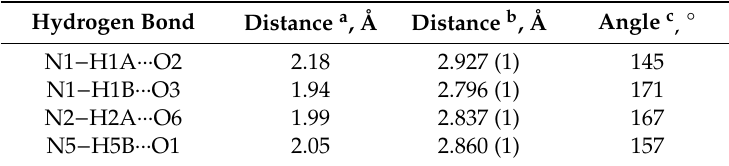
Figure 3. ( a ) View of the asymmetric unit of FMT-MAL, ( b ) hydrogen bonds in FMT-MAL, and ( c ) view of the 3D supramolecular structure of FMT-MAL. Table 3. Hydrogen-bond geometries and interactions for